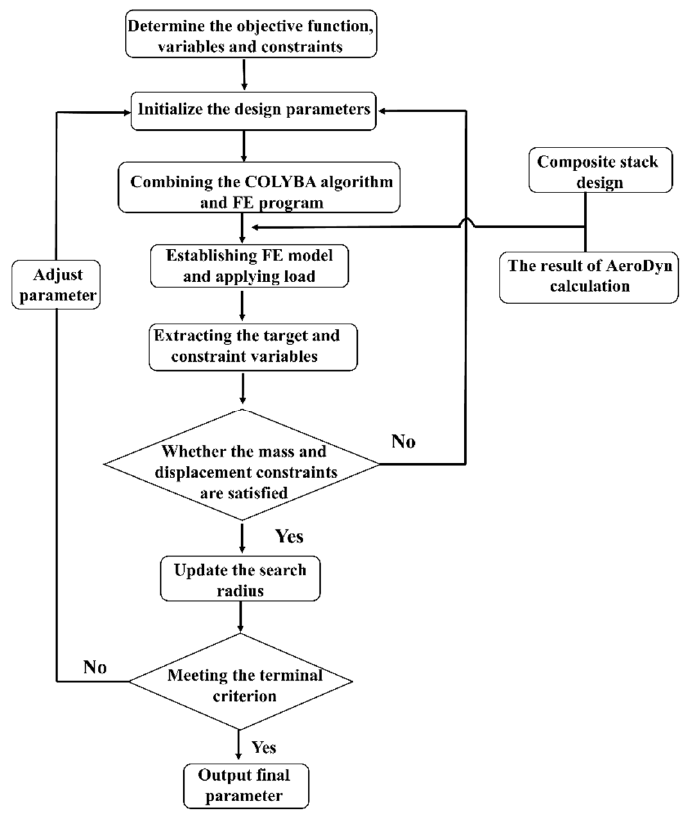
Figure 5. The optimization flowchart.